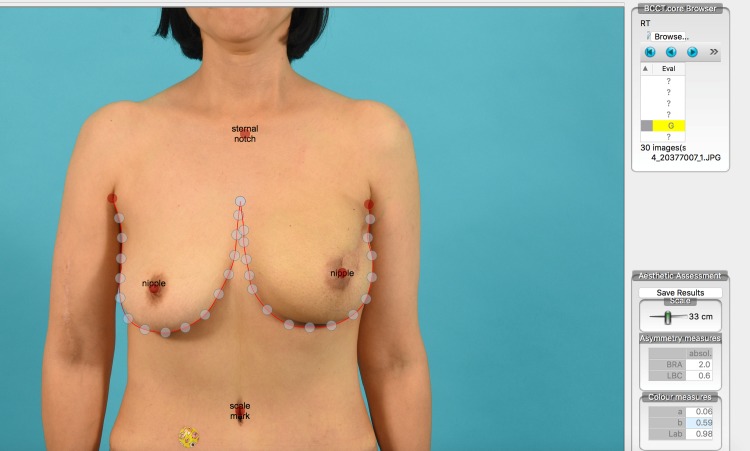
Breast cosmesis analysis.Breast cosmesis assessment using the Breast Cancer Conservative Treatment (BCCT)-core program.